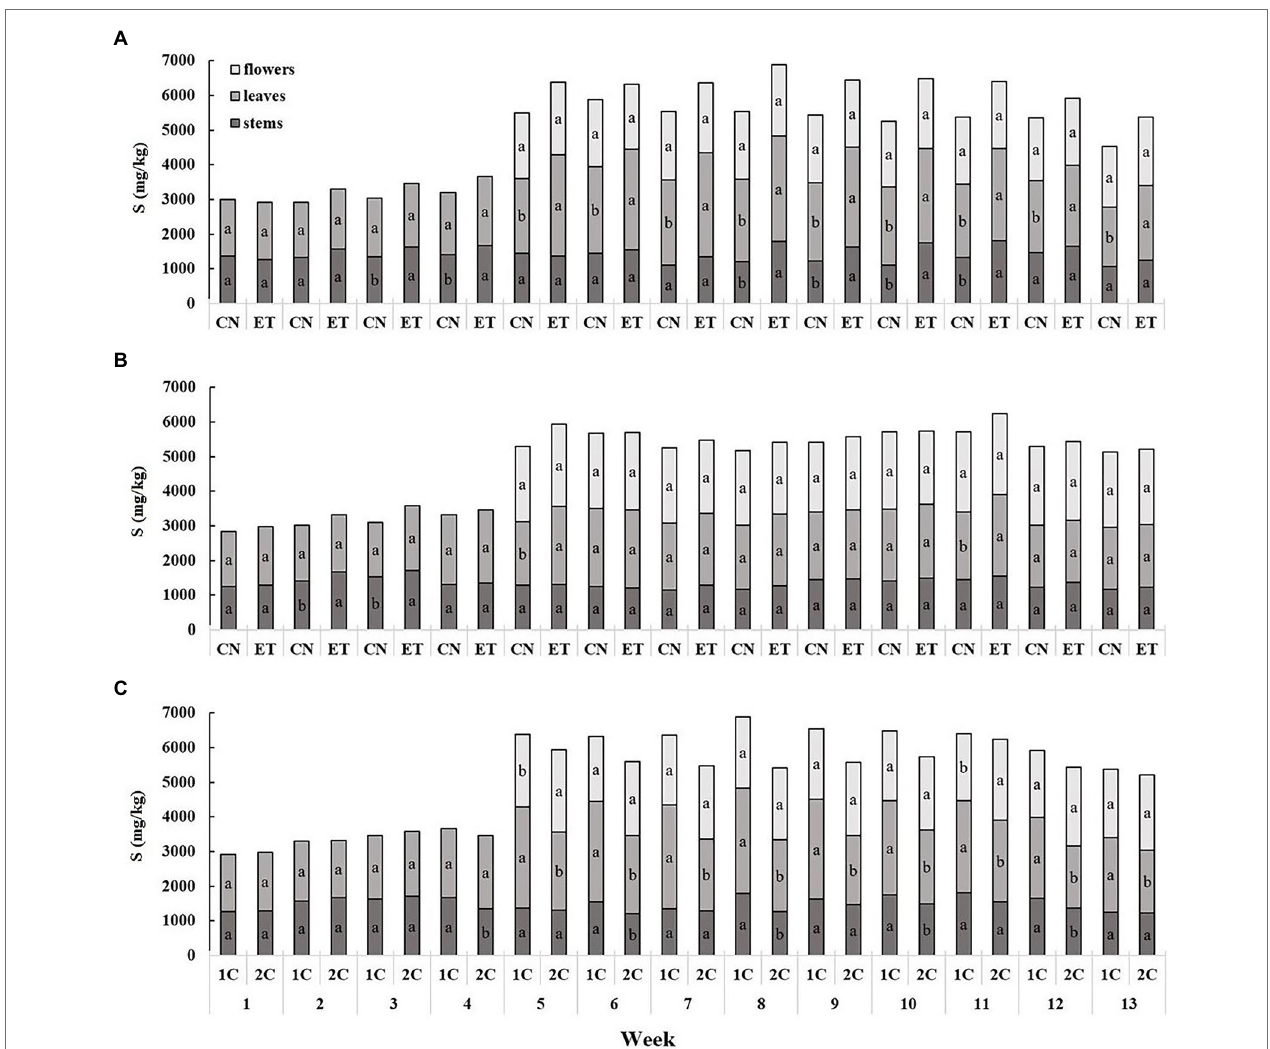
FIGURE 4 | Distribution of sulfur among the organs of medical cannabis plants as affected by amino acid (AA) supplementation and nutrient cycle. S concentration in control (CN) and enhanced treatment (ET) plants with AAs nutritional supplement in recirculation (1C) growing cycle (A) , in drain-to-waste (2C) growing cycle (B) , ETs in 1C and 2C (C) in stems, leaves, and flowers. Data are means ± SE ( n = 3). The different small letters inside the bars represent significant differences within the medical cannabis plant organs (stems, leaves, and flowers) between the variants in a particular week according to Tukey’s HSD test at α =